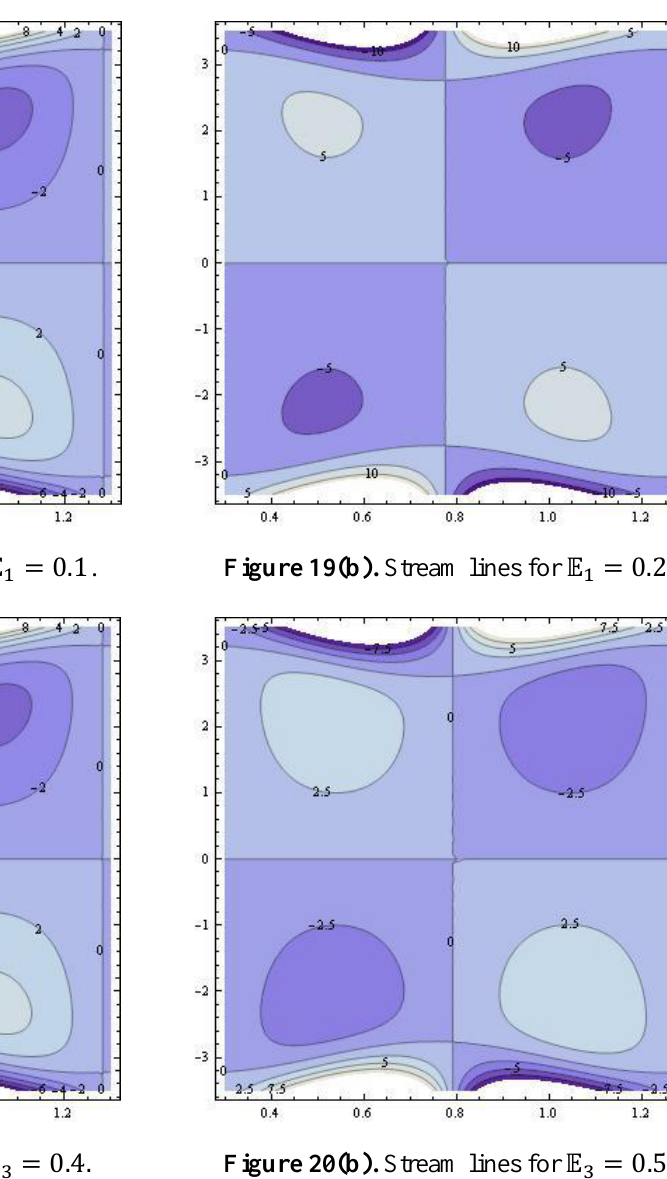
= 0.4. Figure 20(b). Stream lines for 𝔼 3